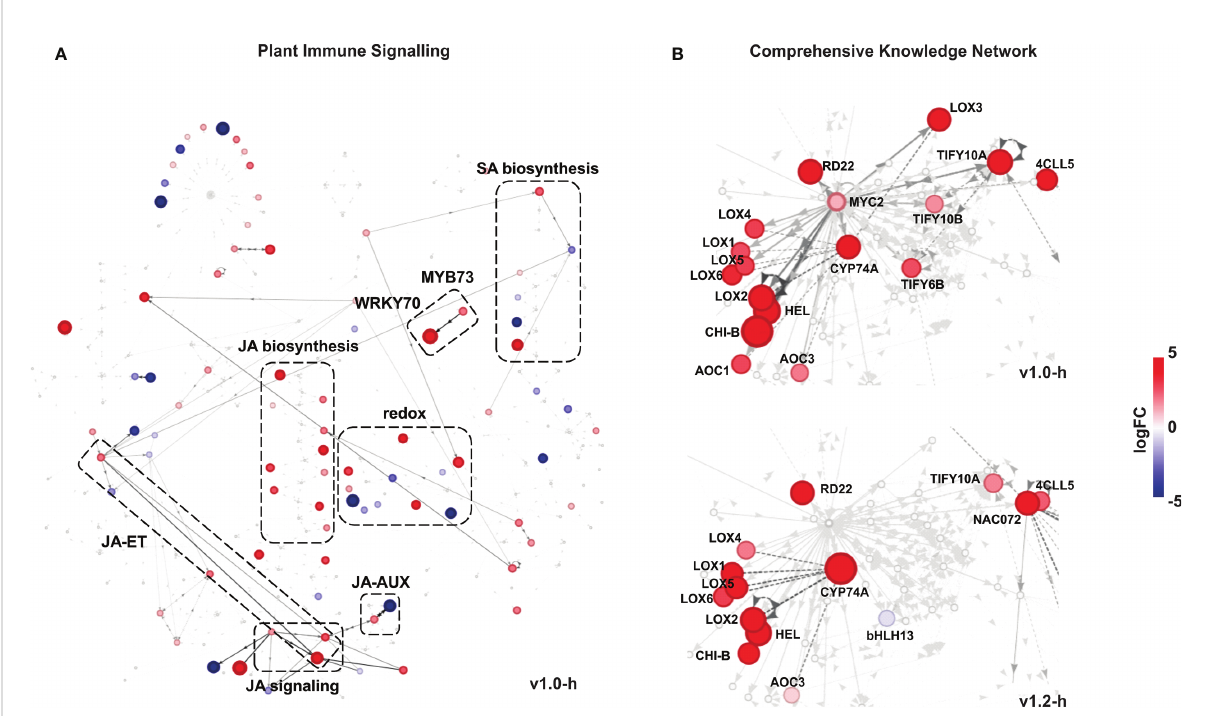
FIGURE 6 Differentially expressed genes in SxP high producers visualised in knowledge networks. (A) Visualisation in the Plant Immune Signalling network with differential expression data for v1.0 high producers (v1.0-h). (B) Visualisation of the MYC2 node and its fi rst neighbours in the Comprehensive Knowledge Network. Differential expression in v1.0 high producers is shown on top and in v1.2 high producers on the bottom. In both networks, only genes with adjusted p-values < 0.05 are shown. When two genes connected with an edge had expression values supported by adjusted p-values < 0.05, the corresponding edge is as shown in darker grey. Colouring and size of nodes denote logFC values, as given on the scale on the right side of the fi gure. Edges describing the reactions between two nodes are directed and represent activation (full line, unilateral arrows), inhibition (full line), or binding (dashed line, bilateral arrows). Full gene descriptions and identi fi ers are presented in Supplementary Table